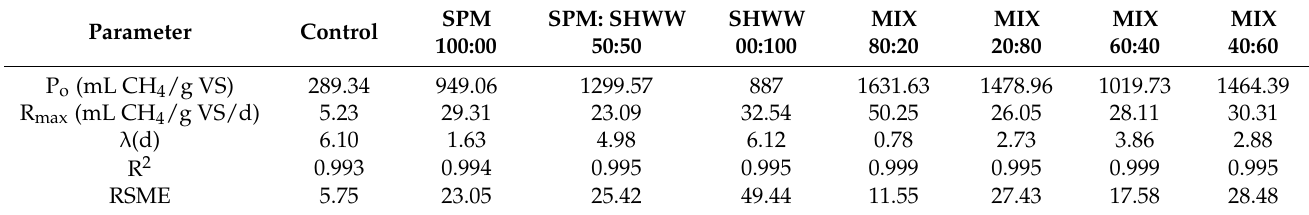
Table 6. Modified Gompertz kinetic